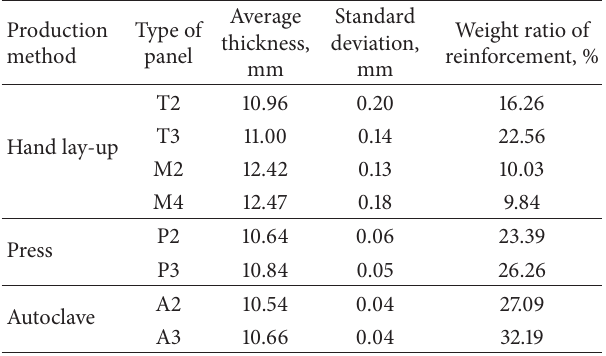
Table 2: Measurement results of sandwich panel samples used for tests.